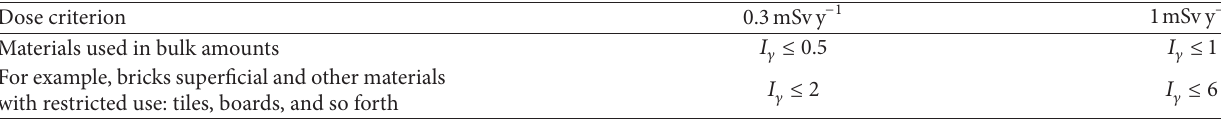
Table 4: Gamma-index ( 𝐼 𝛾 ) values proposed by the European Commission (1999) taking in to account typical way and amounts in which the material is used in a building